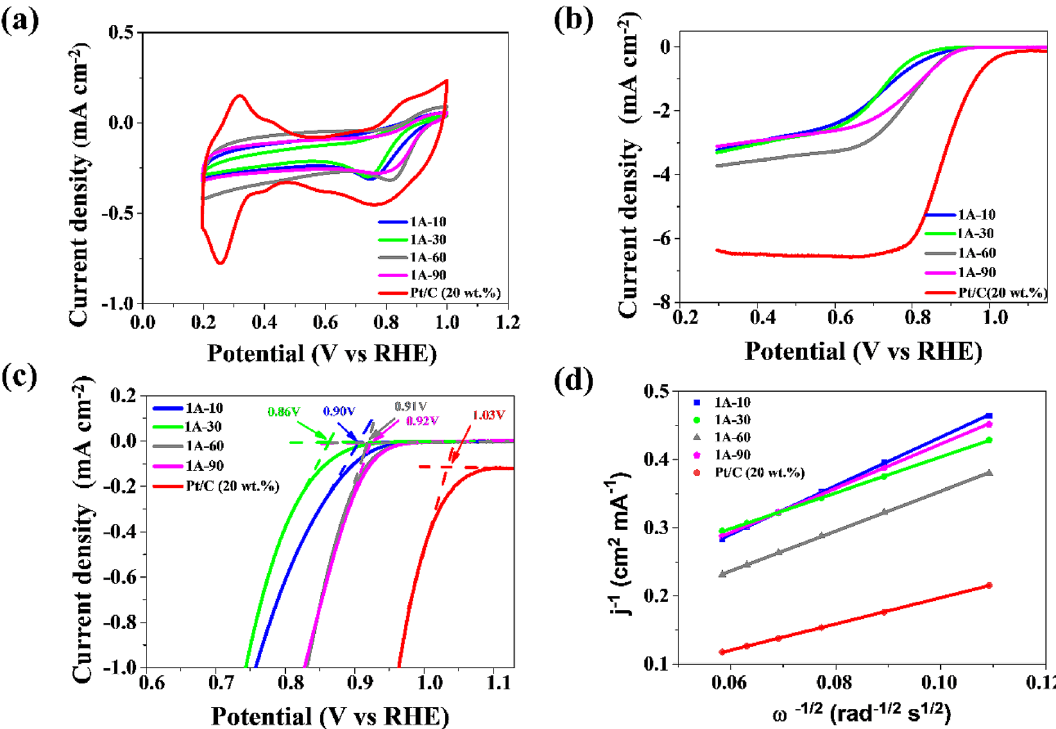
Figure 7. ( a ) CV curves with a scan speed of 100 mV s −1 in O 2 -saturated electrolyte for the 1A-T series and the Pt/C catalyst; ( b ) LSV curve of the obtained samples and Pt/C catalysts (5 V s −1 , 1600 rpm); ( c ) Onset potential of 1A-T and the commercial catalyst; ( d ) Koutecky–Levich plot for the samples at 0.45